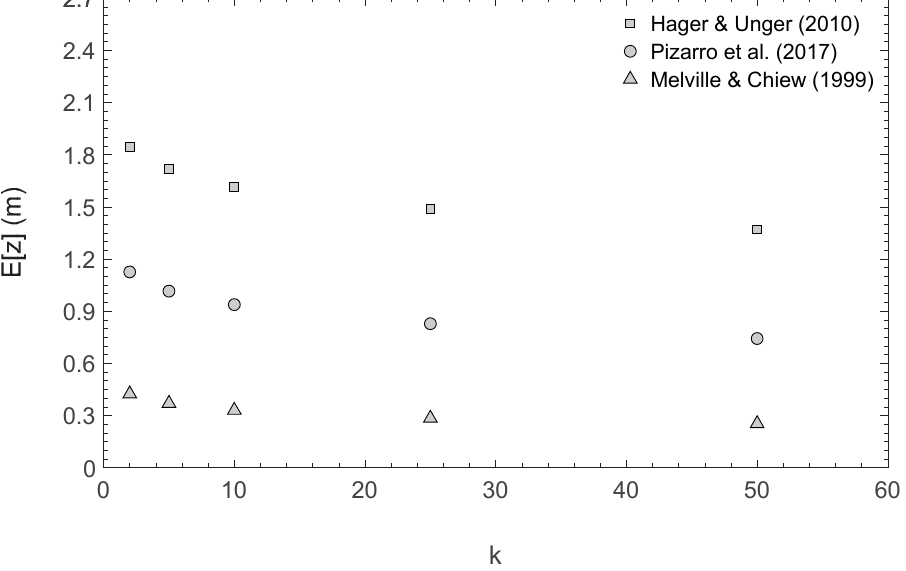
Figure 6. Expected scour depth in function of the hydrograph shape parameter k ( = 2, 5, 10, 25, 50) and employed scour model. Considered bridge lifetime: T = 100 years.